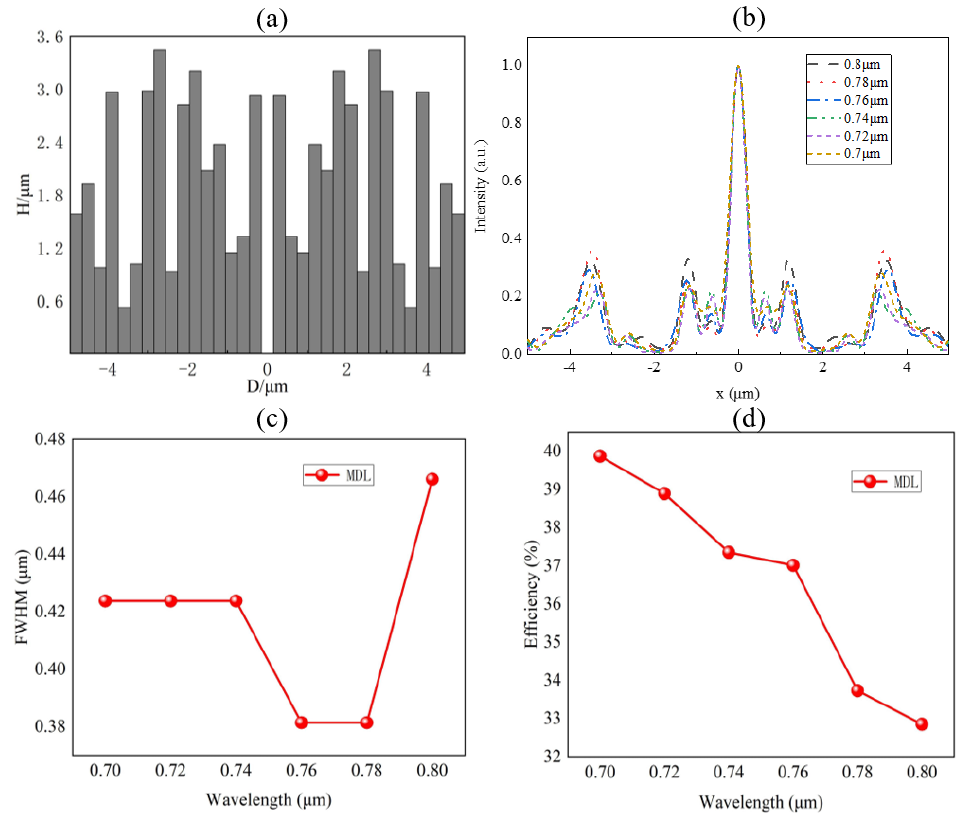
Figure 2. Focusing characteristic of the MDL. ( a ) Optimized height distribution. ( b ) Normalized intensity distribution along transversal axis ( x axis). ( c ) FWHM and ( d ) Focusing efficiency at corresponding focal plane as a function of